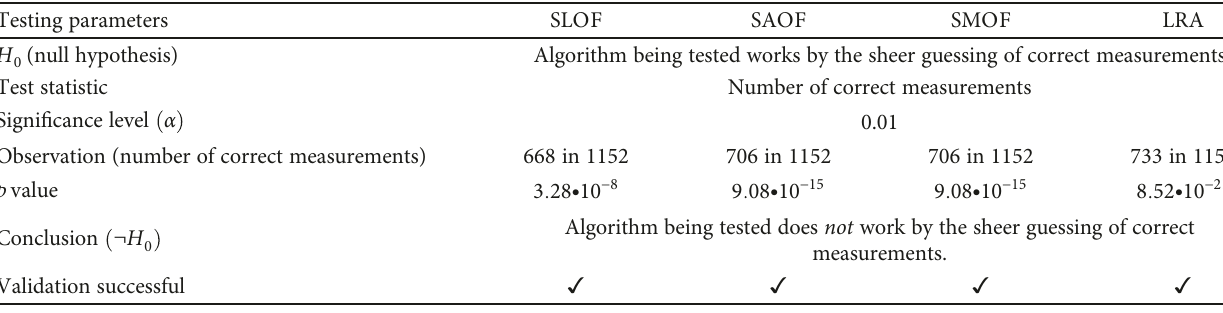
Algorithm being tested does not work by the sheer guessing of correct